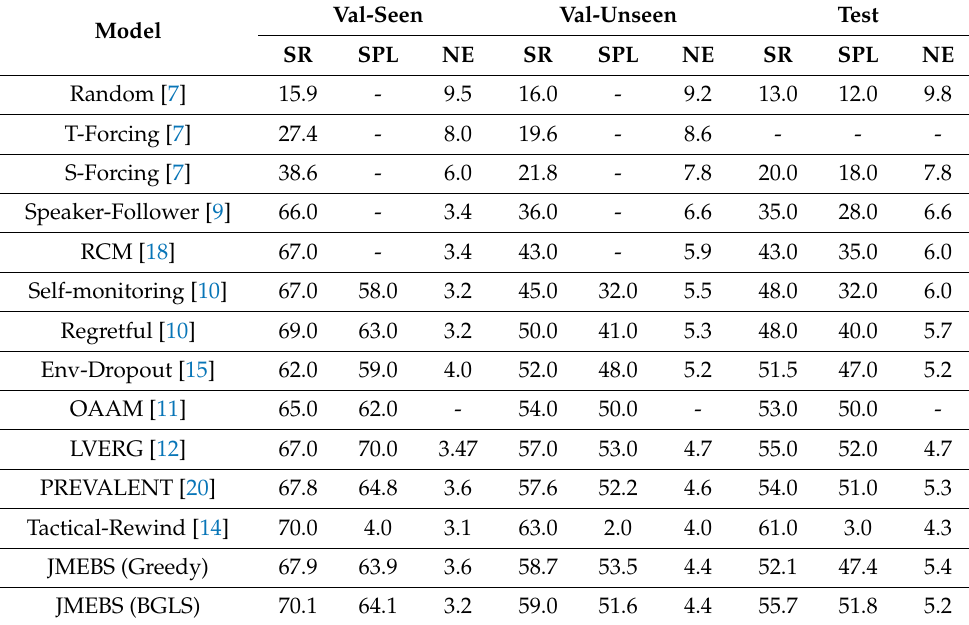
Table 5. Comparison of the-state-of-art